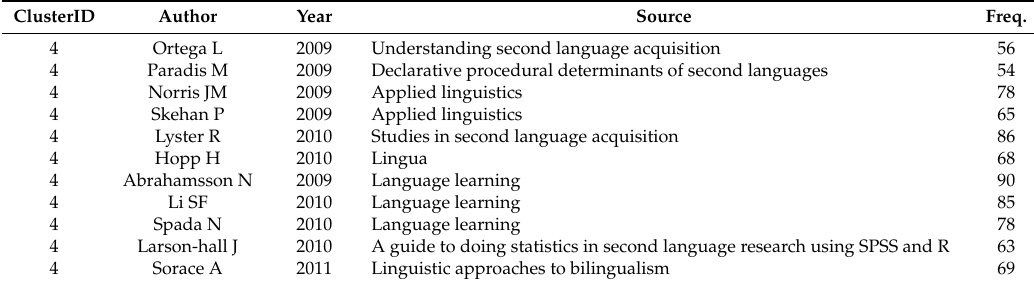
Table 6. The Members of Cluster